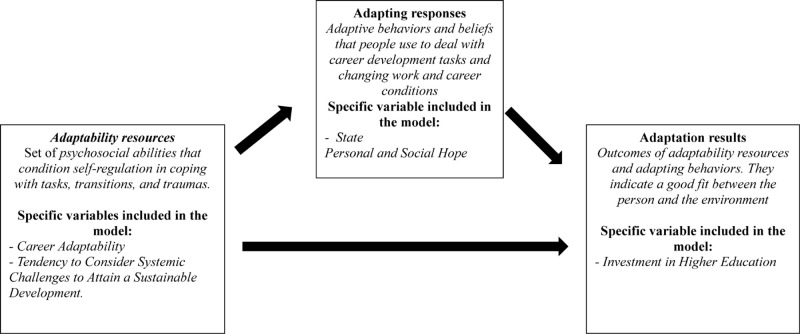
Conceptual framework based on the career construction model of adaptation (Savickas and Porfeli, 2012; Rudolph et al., 2017).